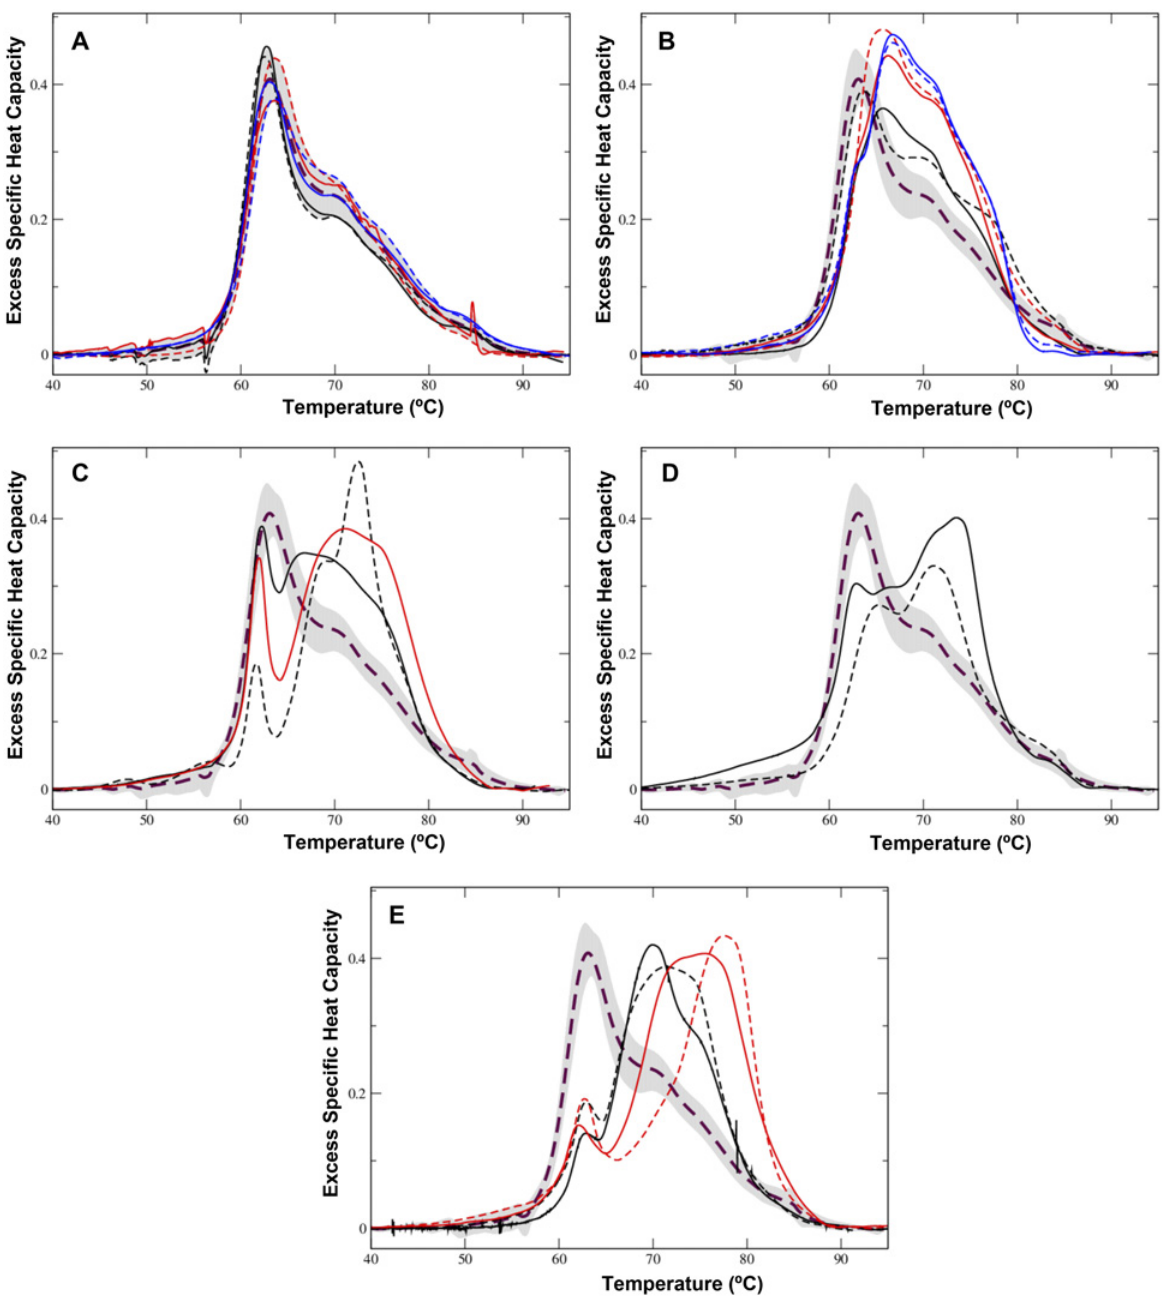
Fig 2. DSC thermograms of serum samples from healthy individuals and patients with MGUS- κ . Samples were gathered as MGUS- κ based on the κ light chain that was found associated with different monoclonal immunoglobulin heavy chains. (A) A set of thermograms obtained from six healthy (control) serum samples. The panel shows an average healthy control plot (dashed brown line) and the standard deviation (shadow). (B) A set of thermograms of serum samples obtained from MGUS patients with IgG κ subtype. (C) Another set of themograms obtained from individuals with IgG κ subtype. For the ease of visualization, thermograms were clustered in either panel B or C based on the similarity of their DSC profiles. (D) Thermograms from patients having IgG1- κ subclass. (E) Thermograms from patients having IgA κ (black) or IgM κ (red) subtypes. For the sake of comparison, the average healthy (control) thermogram (dashed brown line) is presented in all the